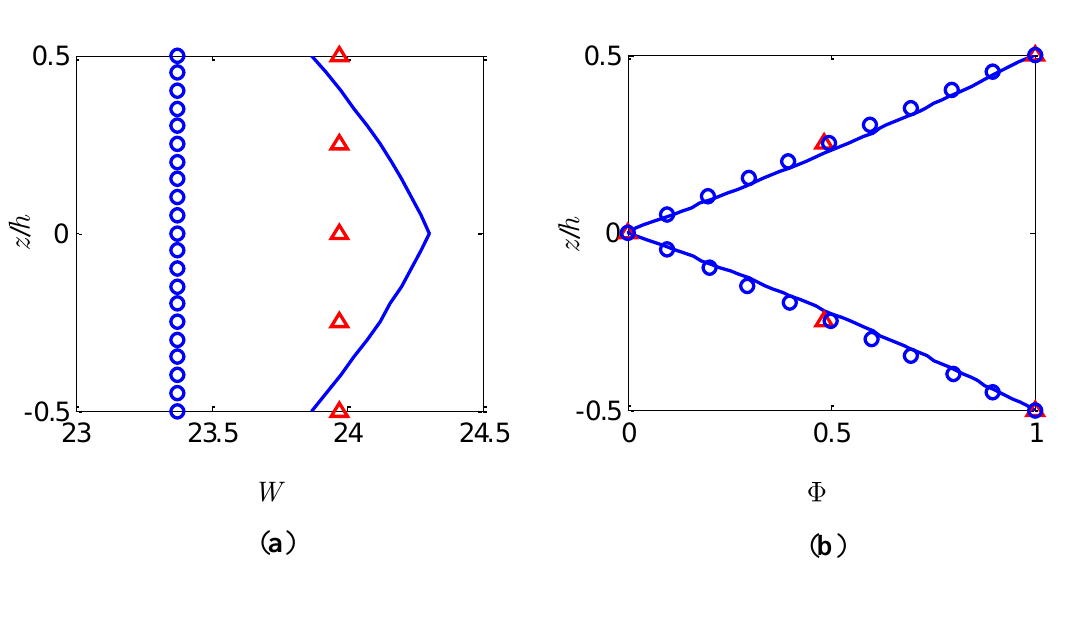
Figure 7. Bimorph actuator of 5 S under potential load. ( a ) Dimensionless deflection; ( b ) Dimensionless electric potential. 3-D FE analysis (full line), present model with 2 n (triangles) and present model with 10 n (small